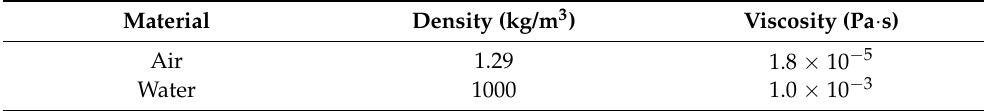
Table 2. Physical properties in the